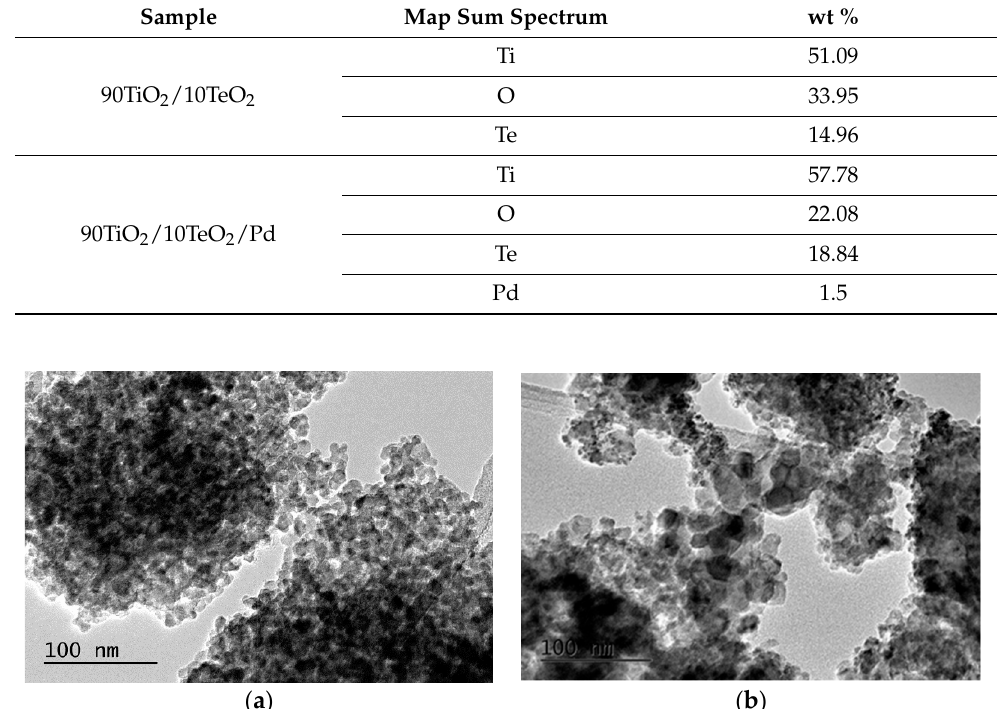
Table 2. Elemental analysis according to TEM.